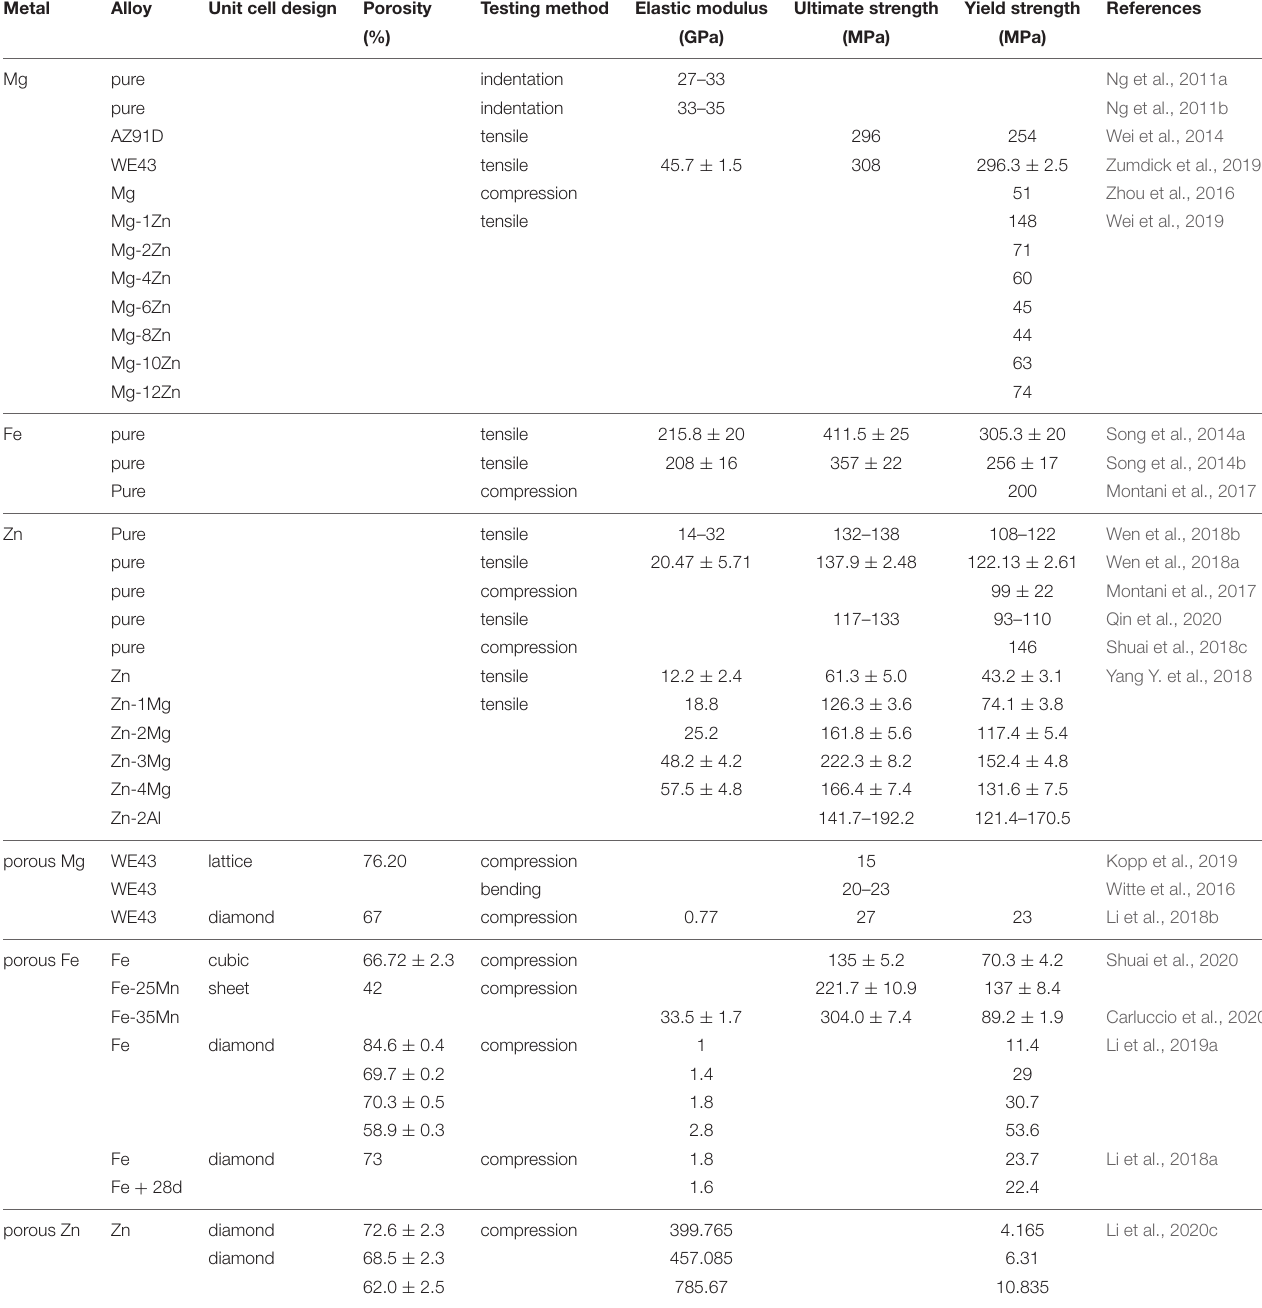
TABLE 1A | Comparison of mechanical properties of selected solid and porous absorbable metals produced by